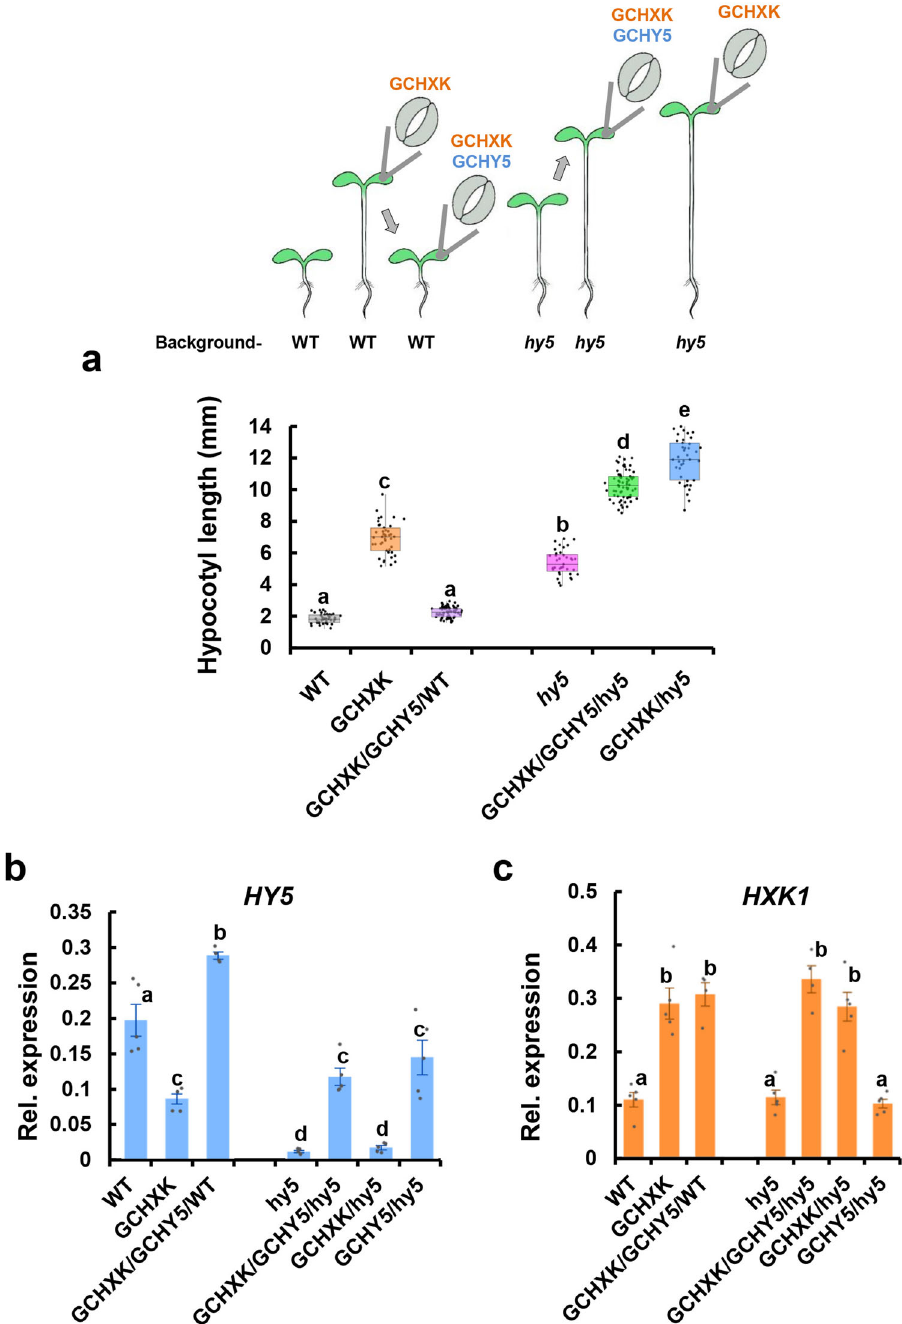
Fig. 6 The ability of GCHY5 to reduce the hypocotyl elongation of GCHXK is dependent on the endogenous HY5. a Hypocotyl lengths of GCHXK/ GCHY5/WT (WT background) and GCHXK/GCHY5/ hy5 ( hy5 background) seedlings grown with 1% sucrose. The box plots extend from the fi rst to third quartiles and the whiskers extend from the minimum to the maximum levels. Lines within the boxes signify median values and gray dots represent individual data points ( n = 30 – 60). The illustration at the top of the fi gure indicates the genes expressed in guard cells (GCHXK, GCHY5), the genomic background (WT or hy5 ). Arrows indicate the hypocotyl-elongation response. b , c RT-PCR expression analysis of HY5 ( b ) and HXK1 ( c ) in GCHXK/ GCHY5/WT and GCHXK/GCHY5/ hy5 seedlings. TUB2 ( β -tubulin) was used for normalization. Data points are means ± SE ( n = 5). Gray dots represent individual data points. a – c Different letters indicate a signi fi cant difference (Tukey ’ s HSD test, P <